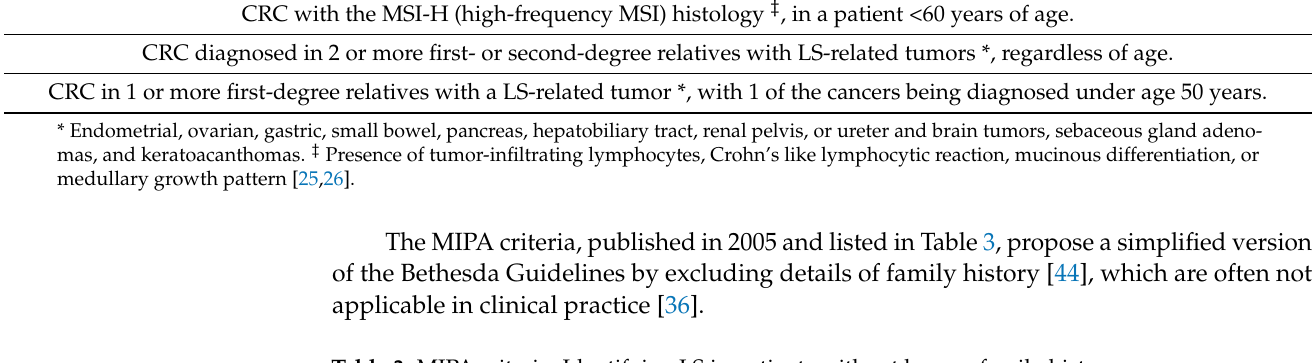
Table 3. MIPA criteria. Identifying LS in patients without known family